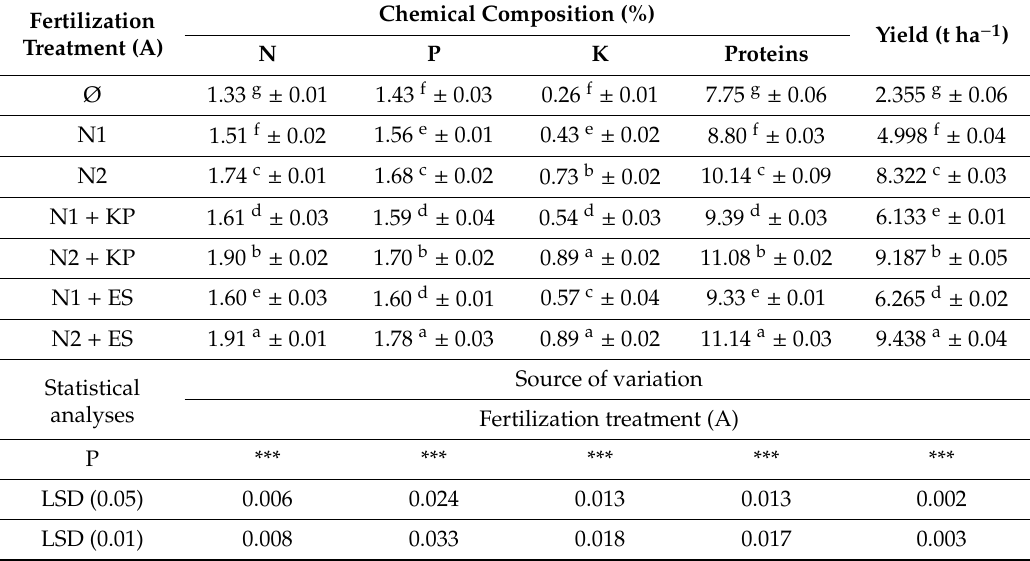
Table 8. E ff ect of the fertilization treatments on yield and average chemical composition of the wheat grain (means ± standard deviation).